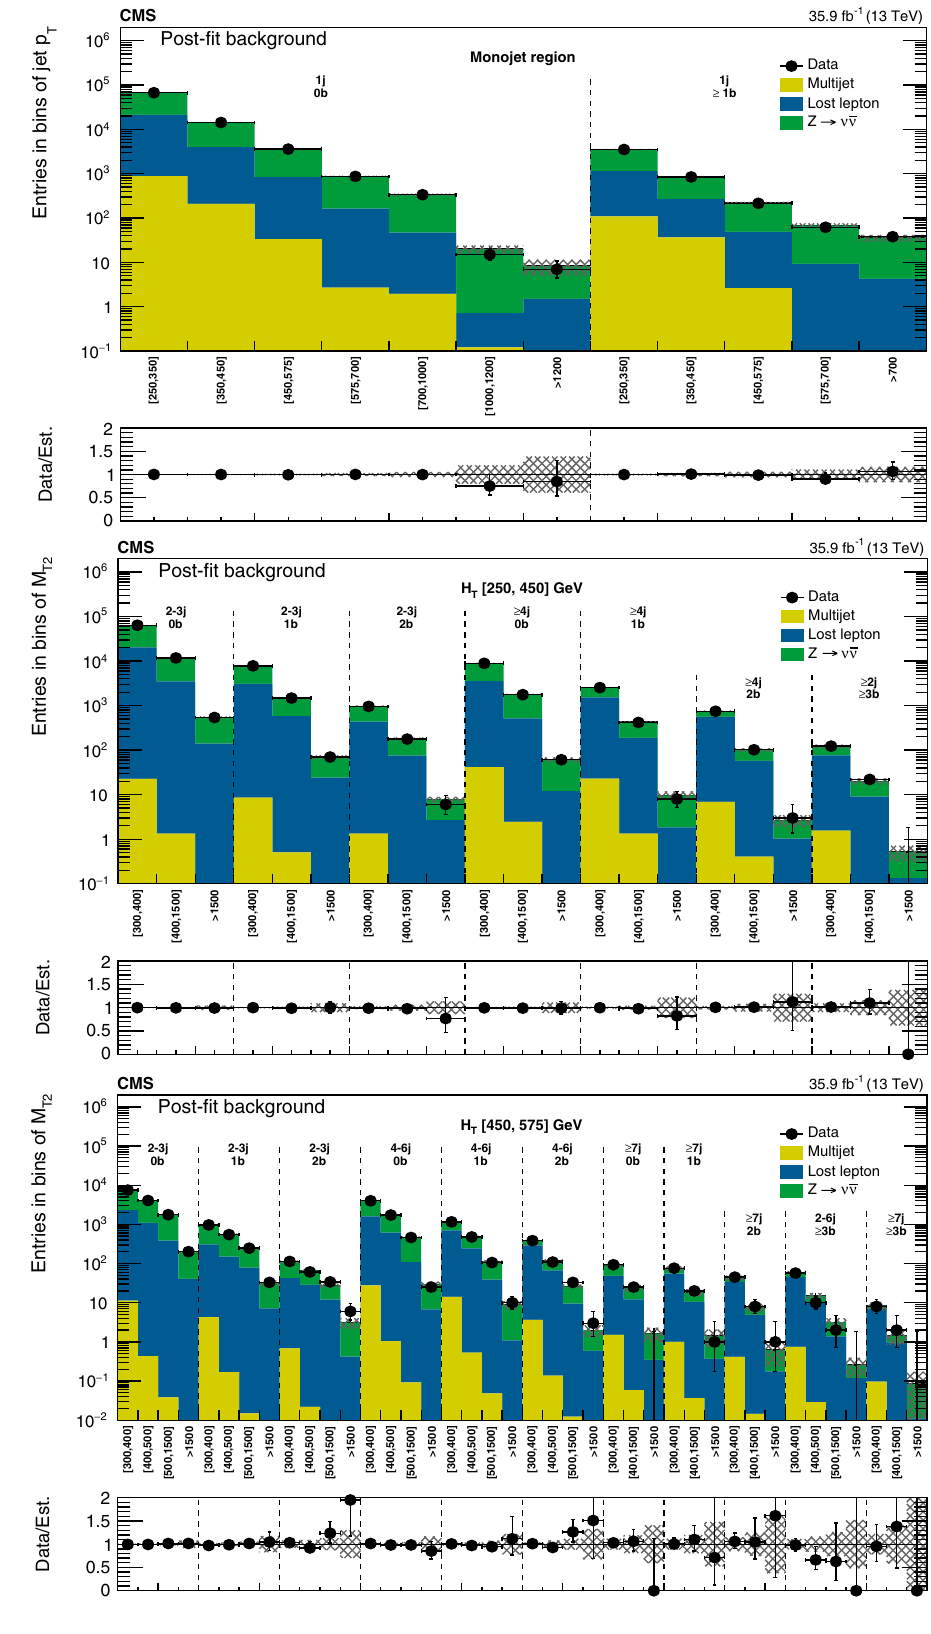
Fig. 12 (Upper) Comparison of the post-fit background prediction and observed data events in each signal bin in the monojet region. On the x -axis, the p jet1 binning is shown in T units of GeV. (Middle) and (lower): Same for the very low and low- H T region. On the x -axis, the M T2 binning is shown in units of GeV. The hatched bands represent the post-fit uncertainty in the background